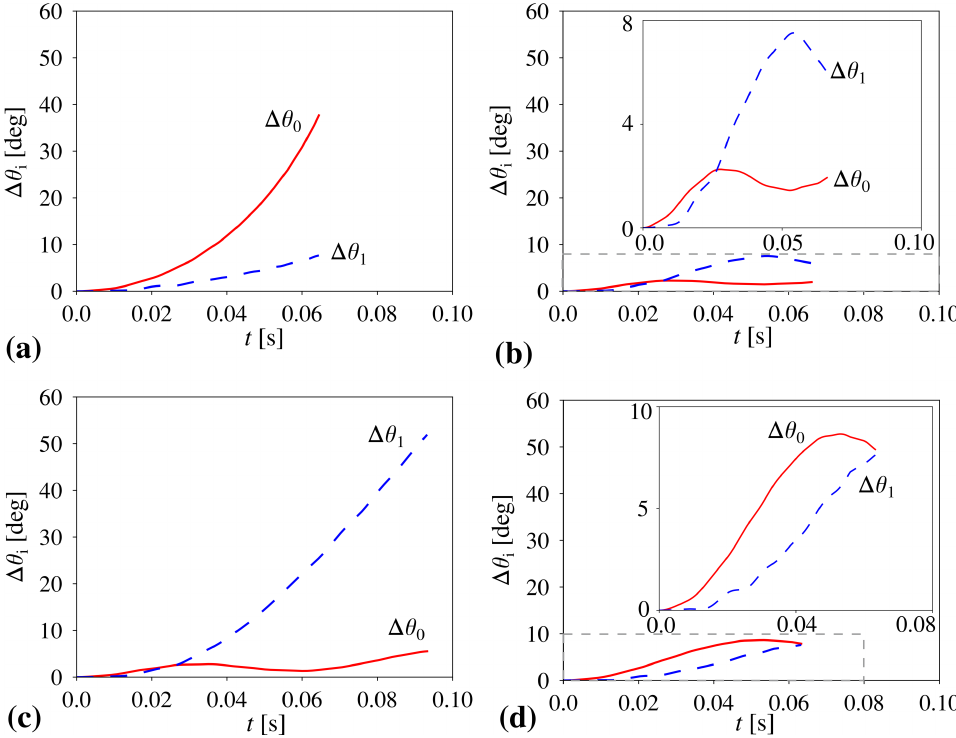
Figure 2. The panels show the behaviour of the system when hinges associated with level 0 and level 1 correspond to different values of a stiffness constant, namely: ( a ) K h 0 = K h 1 = K hS (all hinges are soft, K hS = 1.23 × 10 − 4 J deg − 2 ), ( b ) K h 0 = K h 1 = K hL (all hinges are stiff, K hL = 0.314 J deg − 2 ), ( c ) K h 0 = K hL and K h 1 = K hS (level 0 hinges are stiff and level 1 hinges are soft), and ( d ) Kh 0 = K hS and K h 1 = K hL (level 0 hinges are soft and level 1 hinges are stiff). All of the results presented in this figure correspond to the system having level 1 structural blocks composed of N x × N y = 4 × 4 square units. In addition, ∆ θ i = θ i ( t ) − θ i ( t = 0 ) , where i = 0 or i =